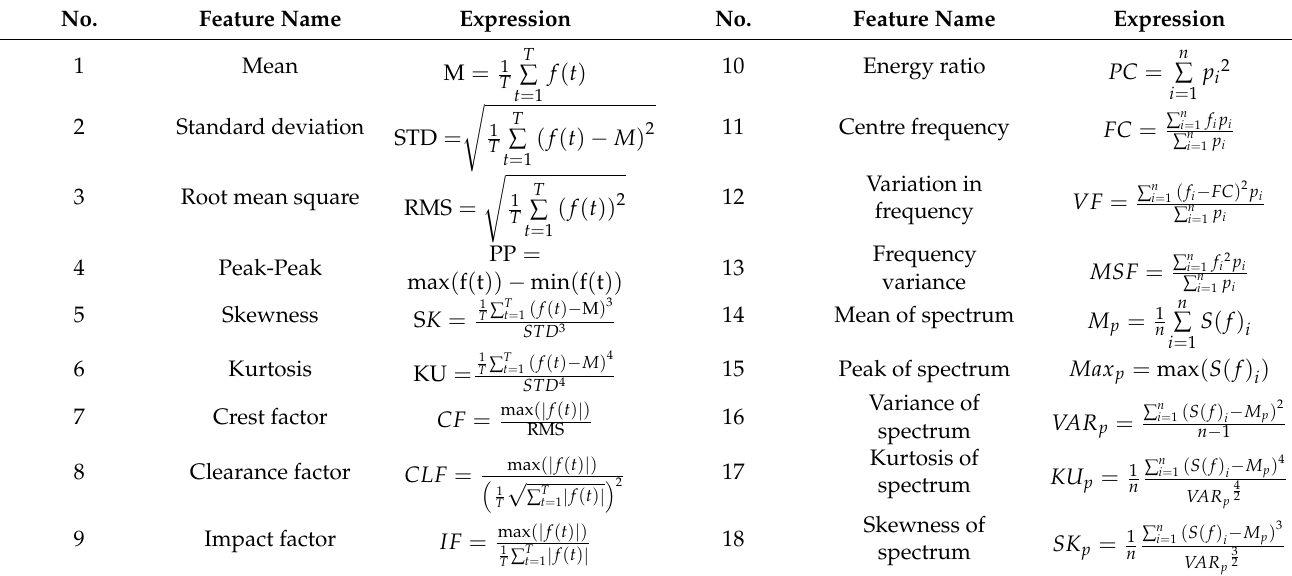
Table 1. Statistical features in time and frequency